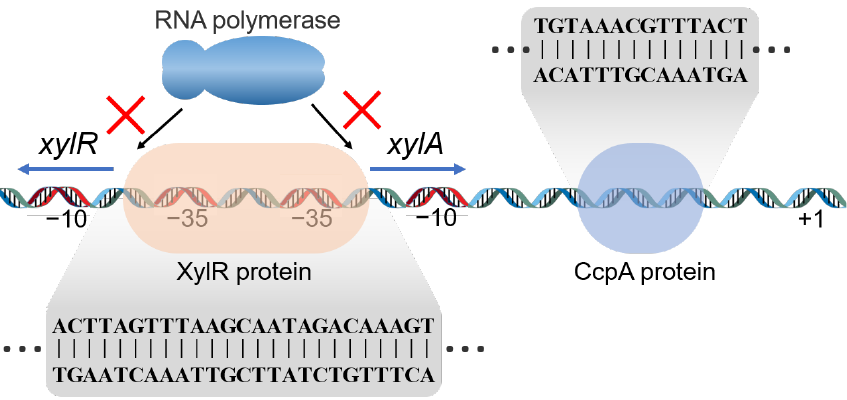
Figure 6. Construction of a xylose operon from P. polymyxa .